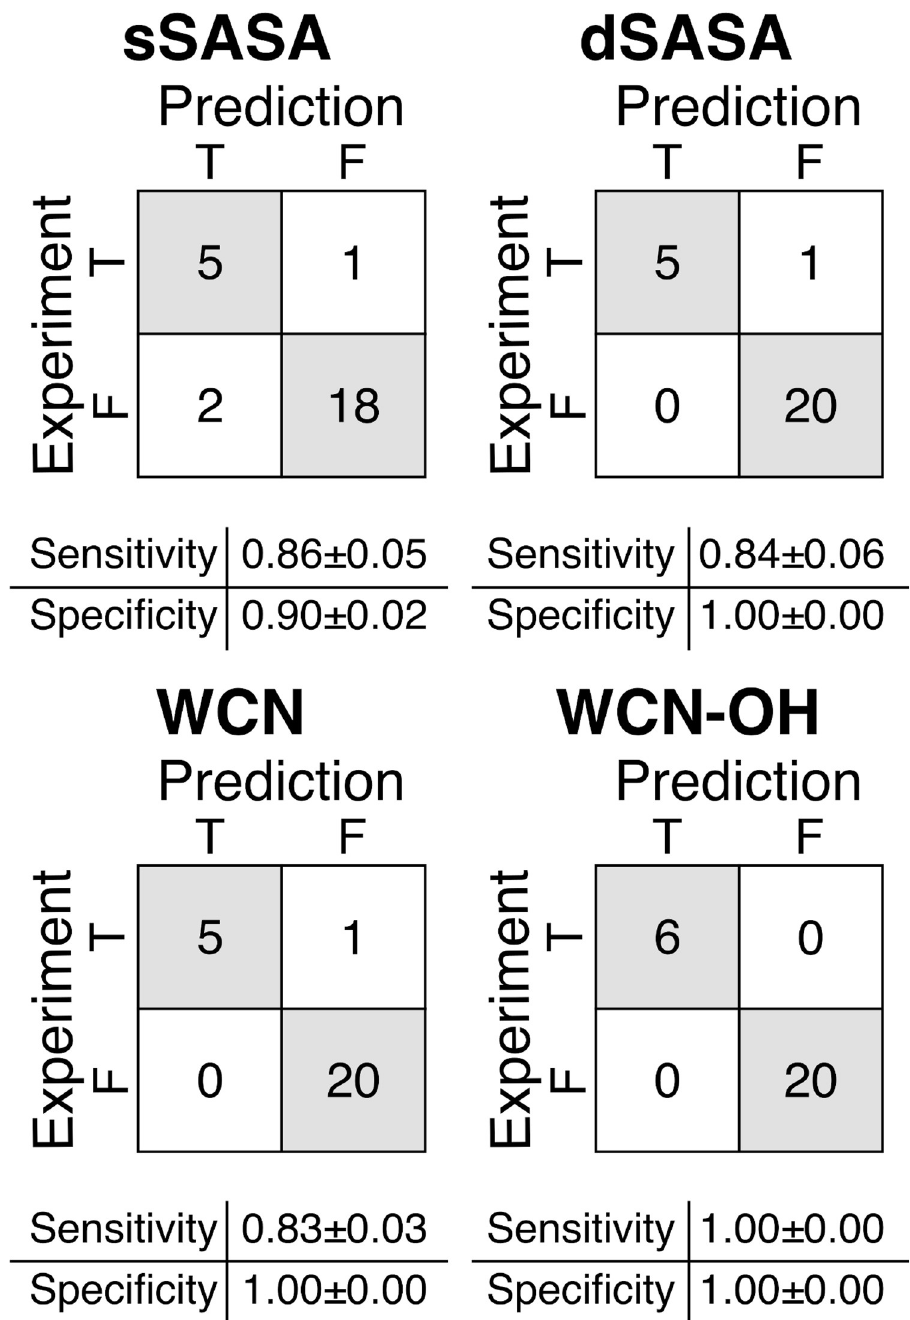
Fig 5. Confusion matrices for the in silico prediction of the oxidation events of the 7 mAbs and 2 ADCs. Confusion matrices reports TP, FN on the first row and FP, TN on the second row. Sensitivity calculated as TP/(TP +FN); Specificity calculated as TN/(TN+FP). TP = True Positive, TN = True Negative, FP = False Positive, FN = False Negative. Error for the sensitivity and specificity were estimated from 50 bootstrap replicates.